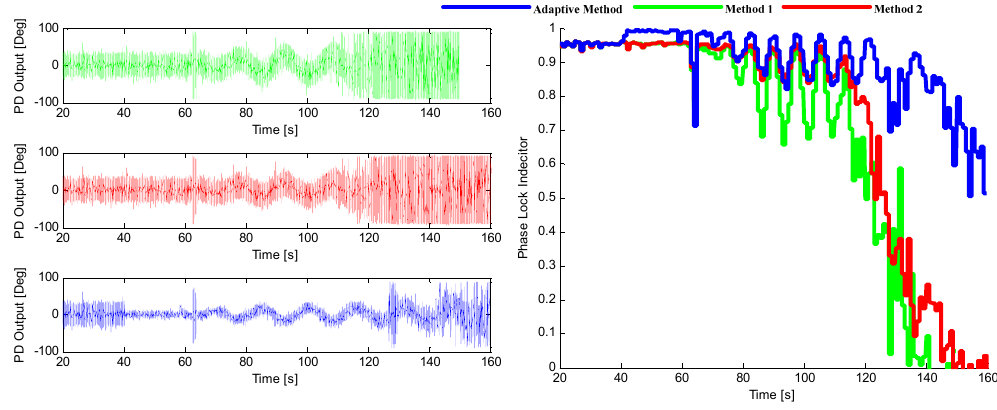
Figure 23. The output of PD ( left ) and the corresponding PLI ( right ) for SV10 in Trajectory 2.